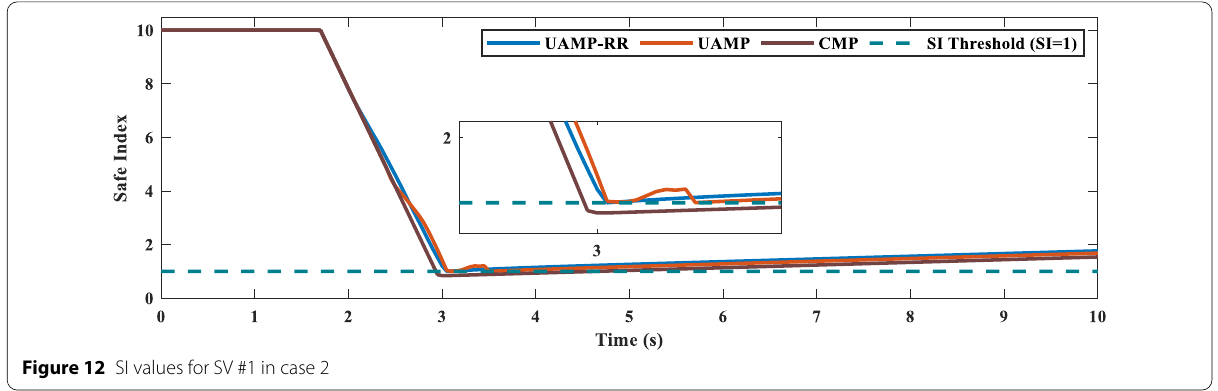
Figure 12 SI values for SV #1 in case 2